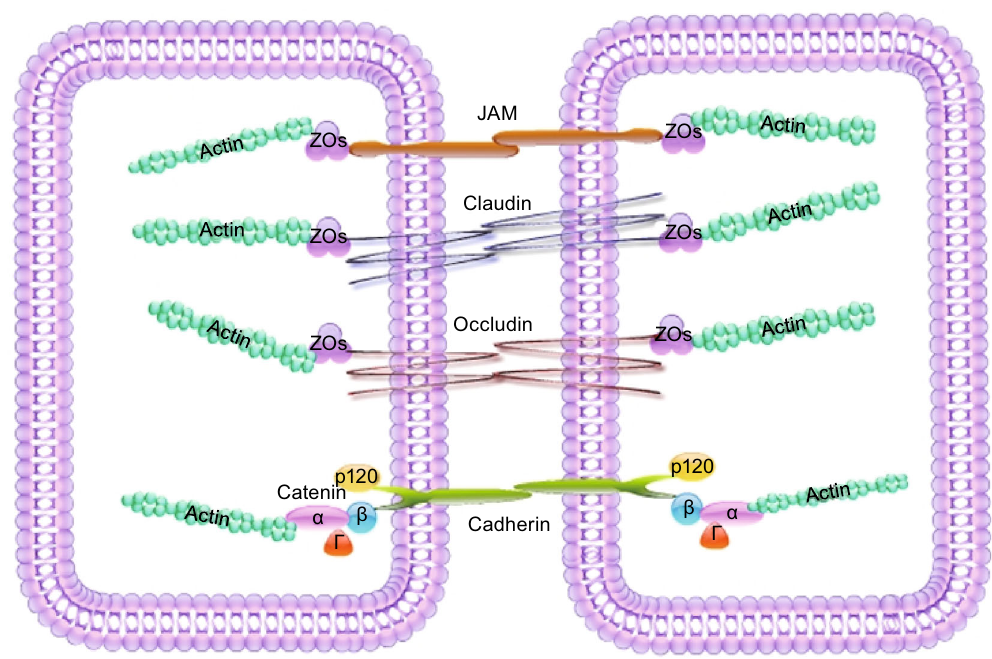
Figure 1. Molecular components of intercellular junctions. Adherens junctions (AJs) are composed of cadherins and catenins ( α -, β -, γ - and p120-catenin). α -Catenin indirectly binds to cadherins via β -catenin or γ -catenin and physically links the complex AJs to the actin cytoskeleton. Tight junctions (TJs) are composed of claudins, occludin, and JAMs. ZOs link with tight junction proteins to